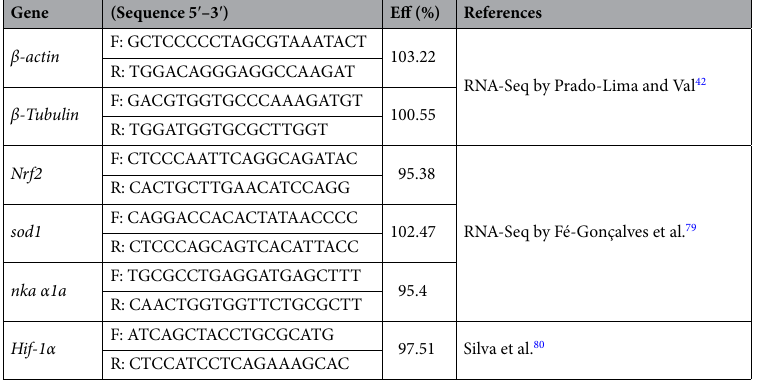
Table 2. Primer sequences used for qPCR in this study. Primers for housekeeping genes ( β-actin and β-Tubulin ) and primers for target genes ( Nrf2, SOD1, NKA α1a and HIF-1α ). Eff = Primer